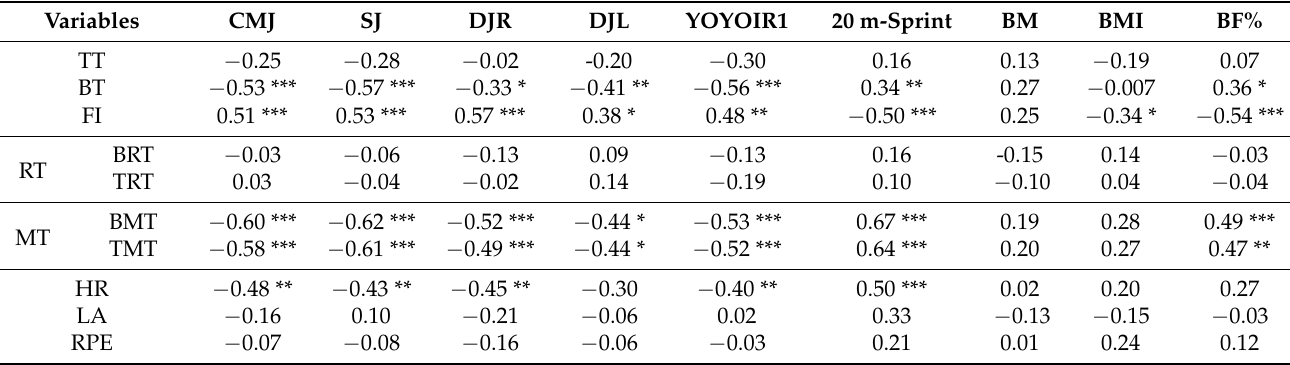
Table 6. Correlations between RRSA 5COD test parameters (dependent), physical fitness tests and anthropometric parameters